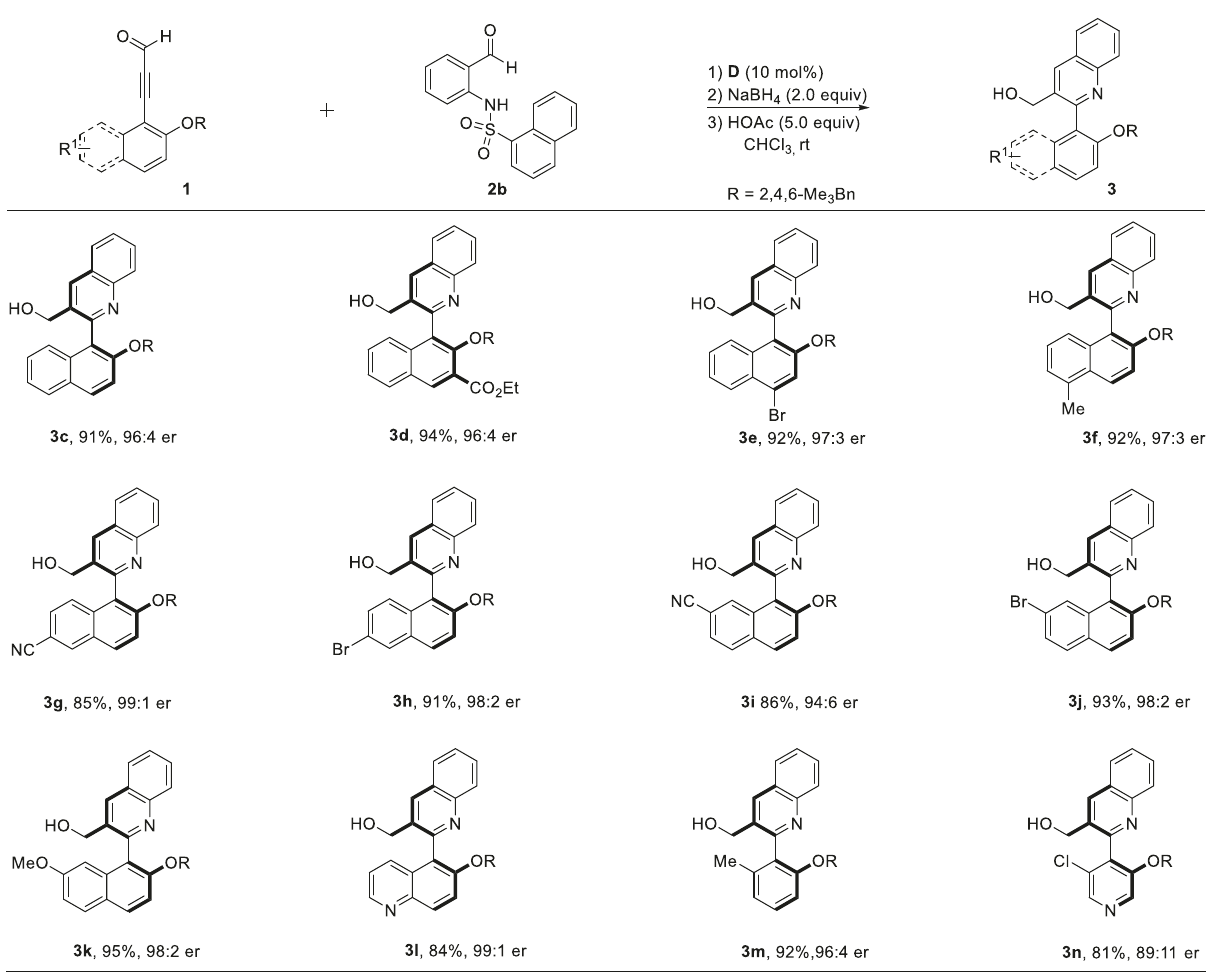
Fig. 2 Scope of ynals. Reaction conditions: a mixture of 1c (0.11 mmol), 2 (0.1 mmol) and catalyst D (10 mol%) in CHCl 3 (1.0 mL) was stirred at room temperature for 24 – 36 h. After the reaction was complete, the reaction was cooled to 0 °C, then MeOH (0.5 mL) and NaBH 4 (0.2 mmol) were added to the mixture and stirred for another 0.5 h at room temperature. At last, HOAc (5.0 equiv) was added to the mixture and stirred for another 2